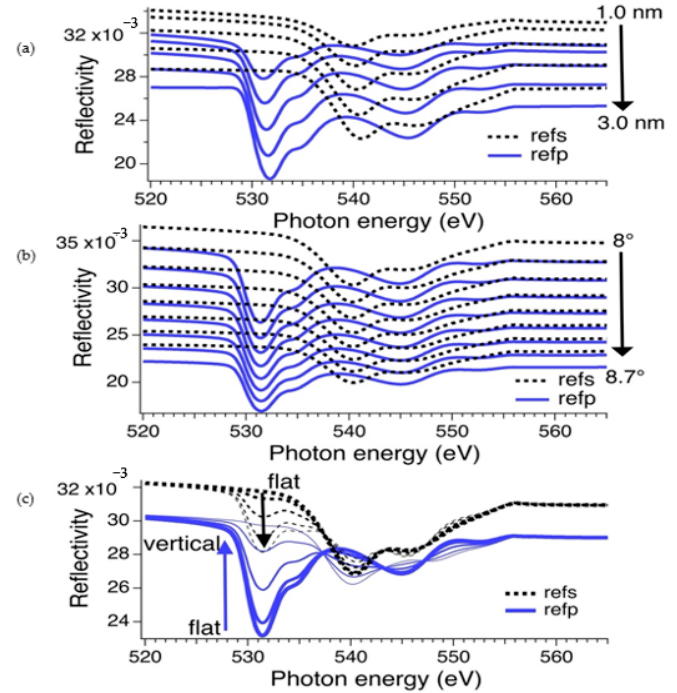
Figure 4. Simulations of the variation of s- and p-reflectivity as a function of ( a ) thin thickness (in steps of 0.5 nm), with fixed grazing incidence of 8 ◦ and flat laying molecules; ( b ) grazing incidence angle (in steps of 0.1 ◦ ), with fixed thickness of 2 nm and flat laying molecules; ( c ) tilt angle of the molecules with respect to flat alignment (in steps of 20 ◦ , from 0 ◦ to 80 ◦ ), with fixed thickness of 2 nm and fixed grazing incidence of 8 ◦